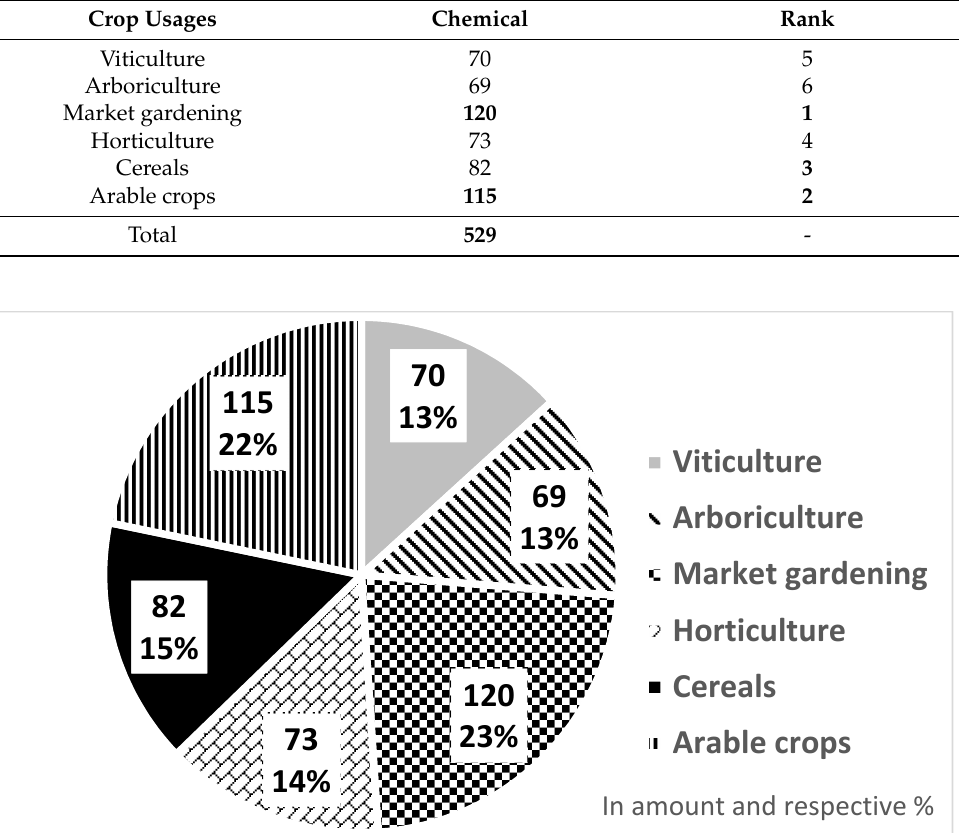
Figure 2. Crop usages of chemicals as a percentage.